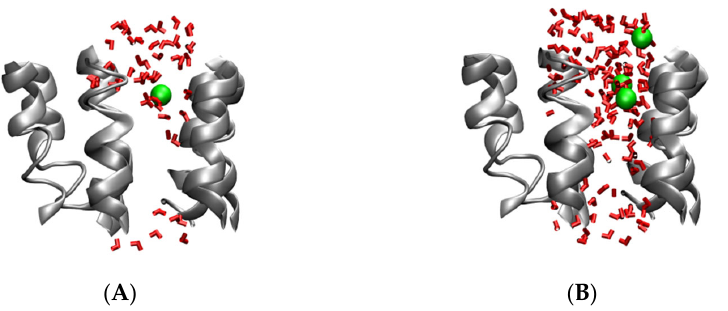
Figure 5. ( A ) is the initial state of the all atomic simulations from a side view; ( B ) the state after 100 ns, all atomic simulations in side view. The water molecules within 0.8 nm of the channel are shown as a red bonds model, Na + ions within 0.8 nm of the channel are shown in a green CPK model and the A β channel is shown by cartoon model in VMD.